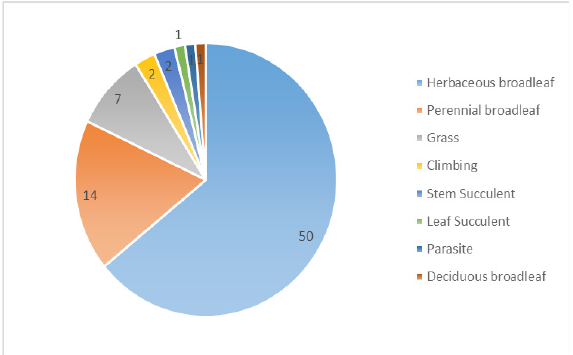
Figure 6. Number of species according to the life forms recorded in the plots of early post-agricultural succession in Cajatambo, Lima (2015 to